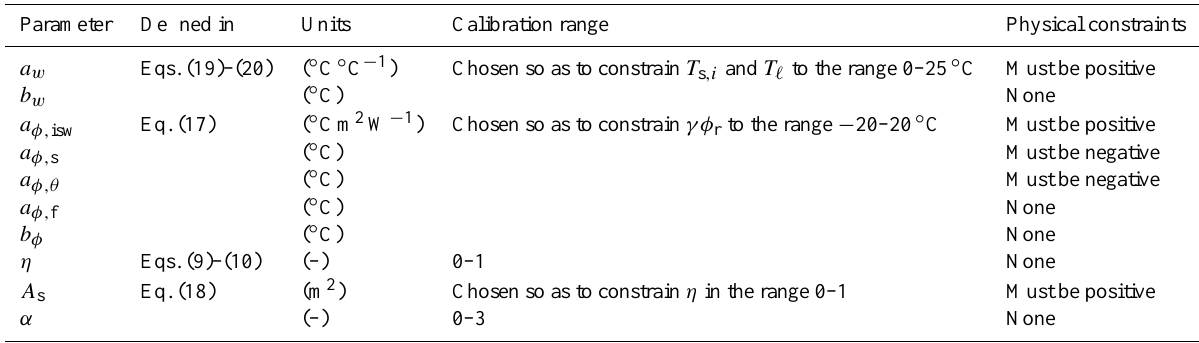
Table 2. Calibration parameters of the physics-inspired statistical model. Parameter